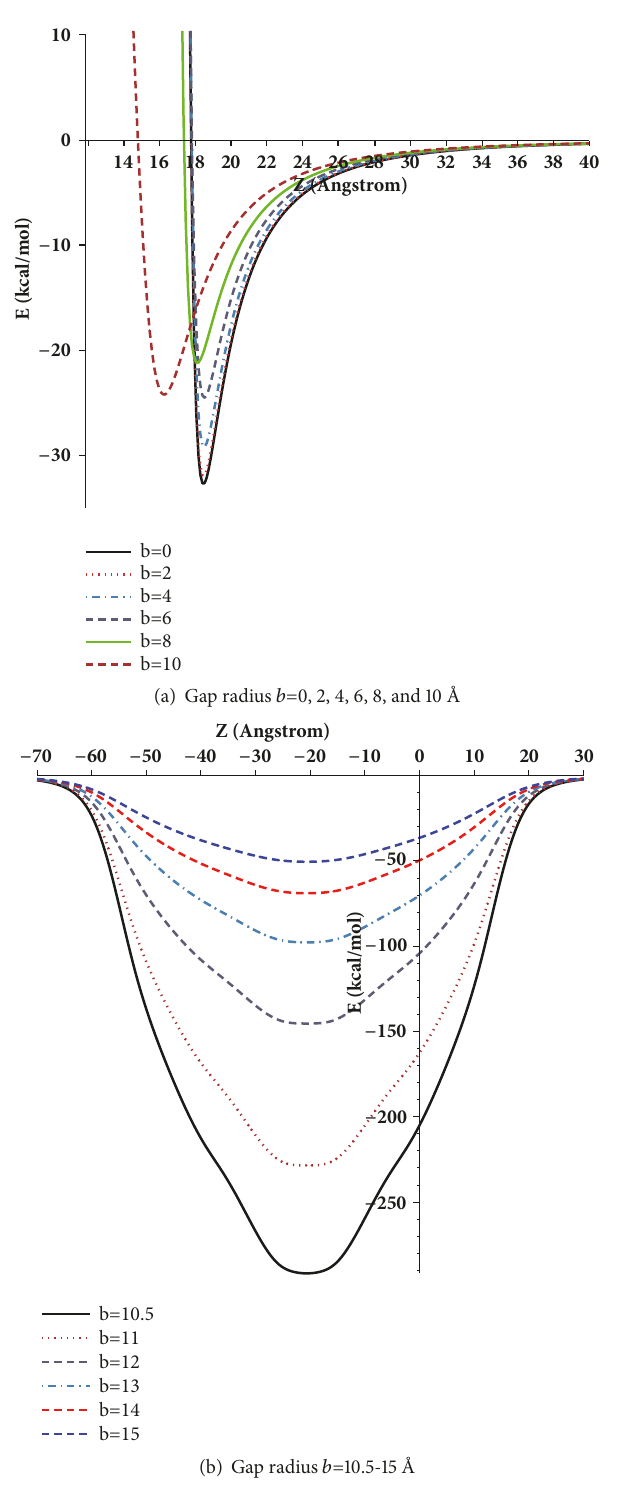
Figure 5: Total energy for ssDNA molecule interacting with different values of the gap radius 𝑏 with respect to the perpendicular distance 𝑍